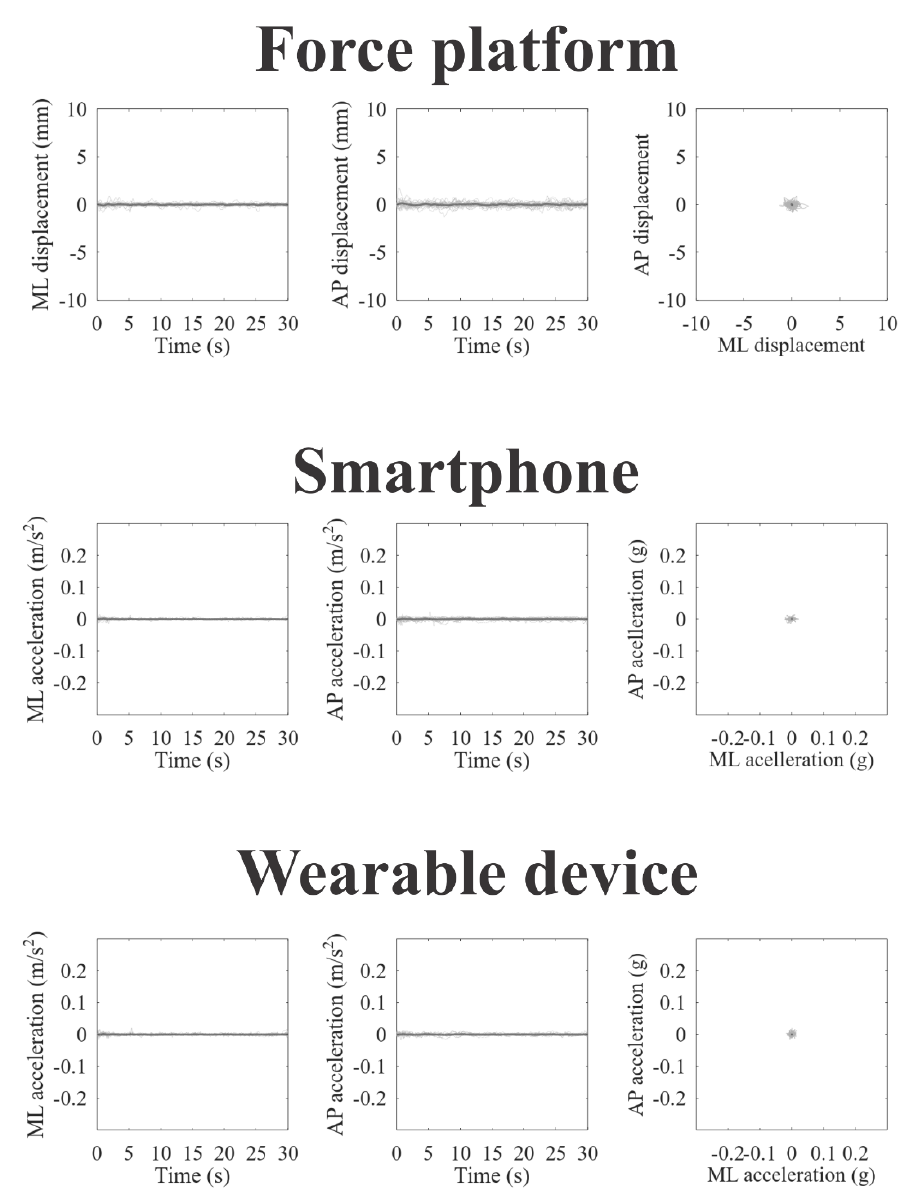
Figure 2. Static balance assessment in open eyes condition obtained from the force platform (upper line plots), smartphone (intermediate line plots), and wearable device (lower line plots). For all instru- ments is shown stabilogram on the mediolateral axes (in the left); stabilogram on the anteroposterior axes; (in the center), and statokinesiogram (in the right) The black lines represent the grand mean recording, while the gray lines represent the individual recordings.